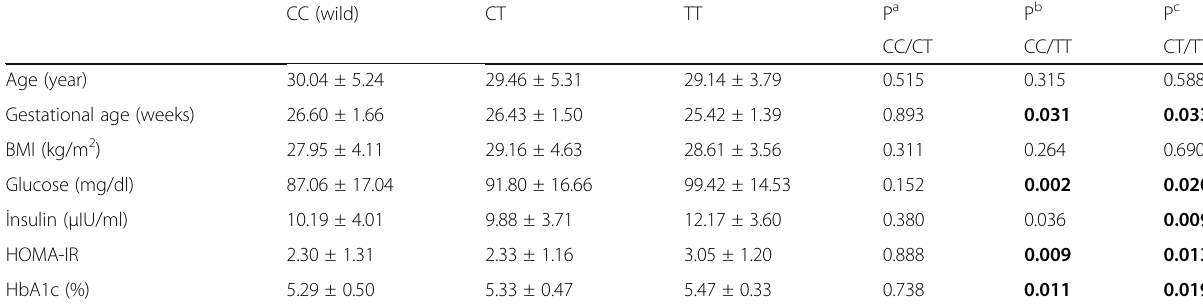
Table 4 Association between the VDR gene FokI SNPs and clinical features of GDM women CC